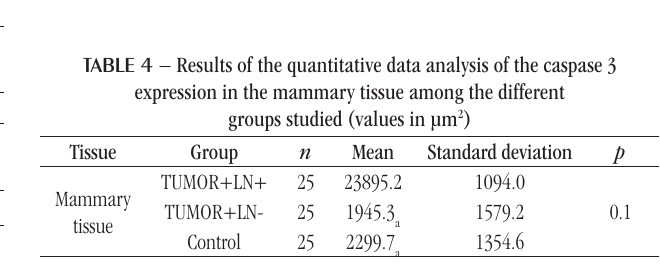
Expression not detected